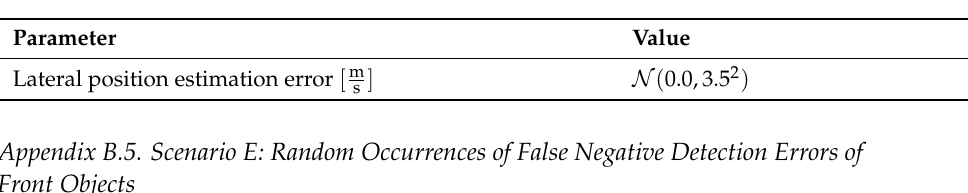
Table A9. Distributions of Scenario D parameters. Ego and object initial state parameters are identical as in Scenario B.